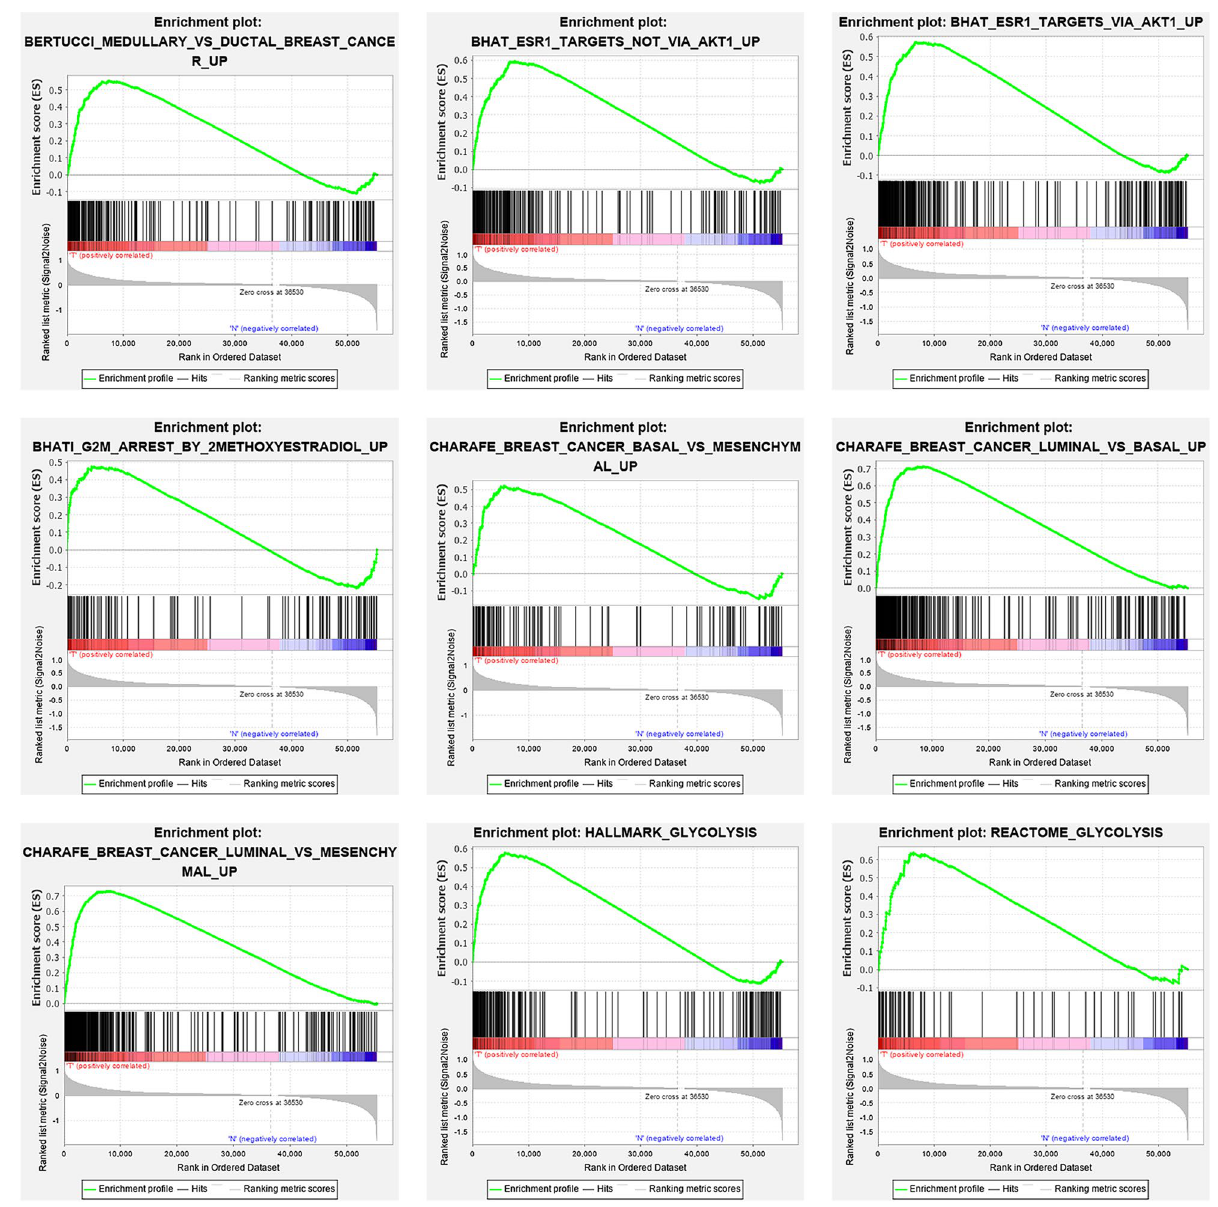
Figure 1. enrichment of nine gene sets with major variations between BC tissues and noncancerous tissues by